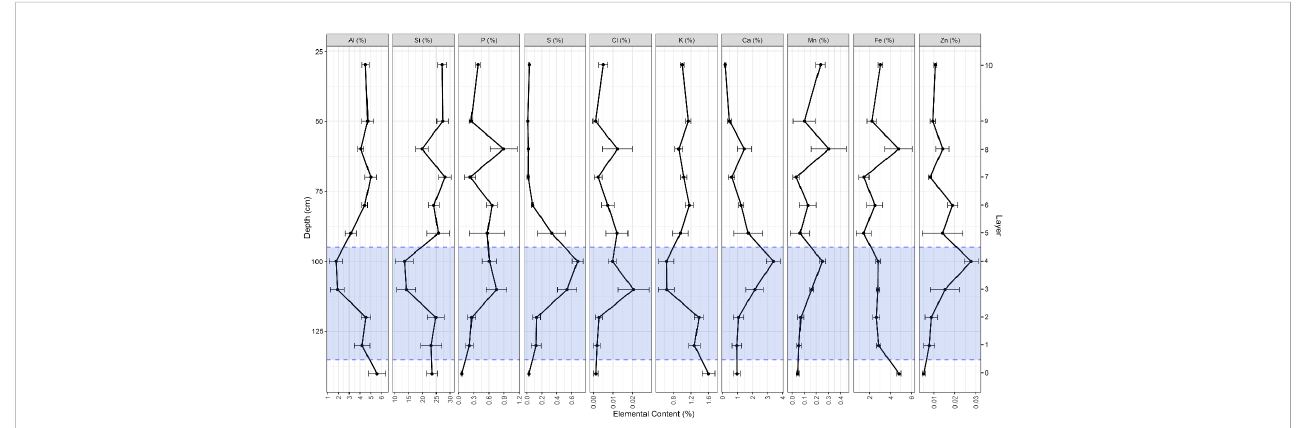
FIGURE 3 Elemental concentration of Al, Si, P, S, Cl, K, Ca, Mn, Fe and Zn. The area in blue denotes the zone of vivianite formation observed